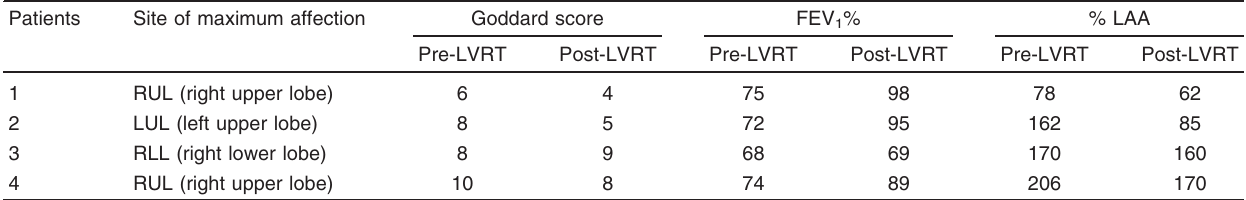
Table 3 The Goddard score, forced expiratory volume in the first second, and percentage low-attenuation area of the four selected patients for lung volume reduction therapy before and after the interventional process Patients Site of maximum affection Goddard